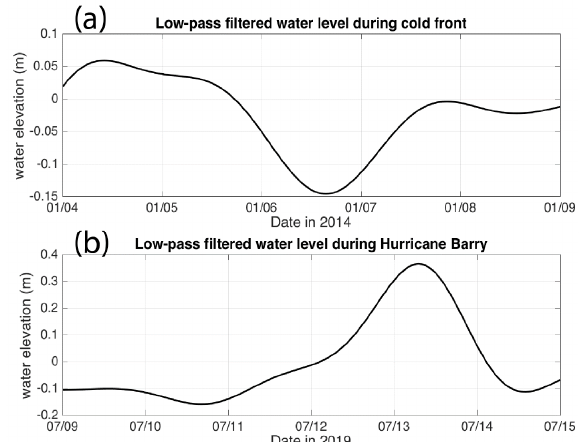
Figure 5. Water level variation during different weather types. ( a ) Low-pass filtered water level during cold front; ( b ) Low-pass filtered water level during Hurricane Barry.